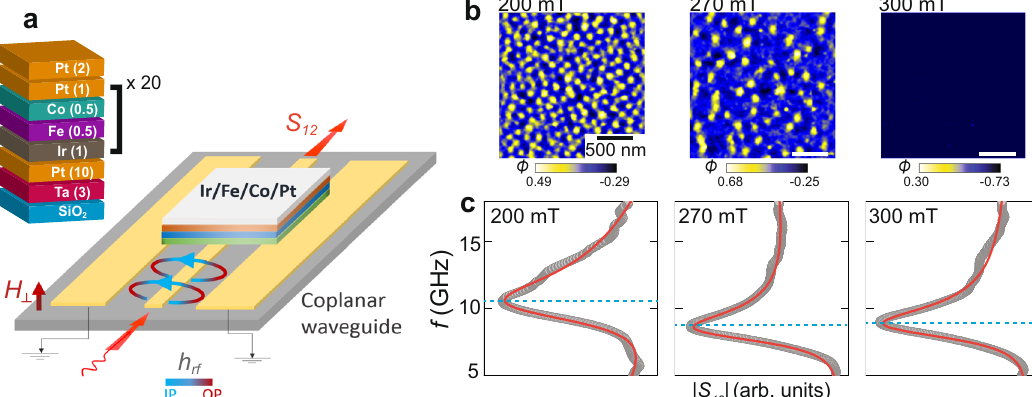
Fig. 1 Characterising resonances across the magnetic phase diagram of [Ir 1 Fe 0.5 Co 0.5 Pt 1 ] 20 . a Experimental geometry: a microwave signal applied to the coplanar waveguide sample-holder creates an oscillating in-plane (IP) magnetic fi eld h rf in our [Ir 1 Fe 0.5 Co 0.5 Pt 1 ] 20 heterostructure, which lies perpendicular to the out-of-plane (OP) dc fi eld H ⊥ . The absolute value of the microwave transmission through the waveguide, S 12 , is measured using a vector network analyser in two-port mode. Magnetic resonance within the sample leads to an increased microwave absorption and hence a reduction in S 12 . The inset shows a cross-sectional view of the multilayer stack. b Magnetic force microscopy (MFM) images of [Ir 1 Fe 0.5 Co 0.5 Pt 1 ] 20 acquired at temperature 300 K in dc fi elds of 200, 270 and 300 mT. At these fi elds, the sample exhibits a dense skyrmion array, isolated skyrmions and ferromagnetic order, respectively. The colour bar shows the phase shift ( ϕ , in degrees) of the MFM cantilever oscillations, which is proportional to the OP magnetisation component m z . c Frequency-sweep microwave absorption spectra acquired at the same three magnetic fi elds. Resonance is visible as a local minimum in S 12 at each fi eld (blue dashed lines). We extract the resonant frequency dispersions f ( H ⊥ ) using a standard Dysonian peak- fi tting routine 37 (red lines) on raw S 12 ( f , H ⊥ ) absorption spectra (grey